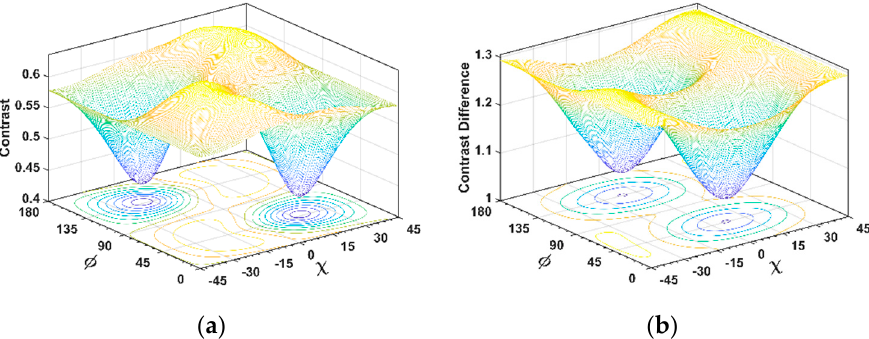
Figure 2. Mild temporal decorrelation-affected data: ( a ) A 3D view plot of polarimetric synthetic aperture radar (SAR) tomography (TomoSAR) focusing capability; ( b ) polarization TomoSAR dispersion obtained by subtracting Figure 2a from Figure 1.